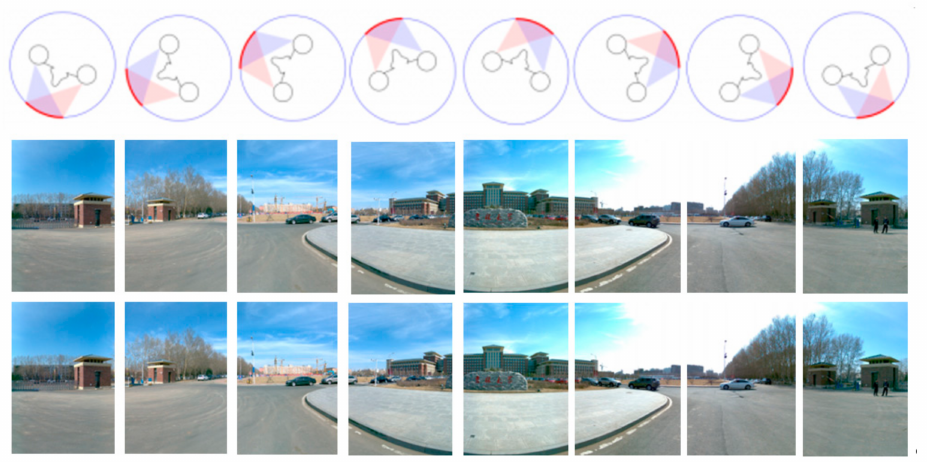
Figure 5. The calculation of stereoscopic images in different